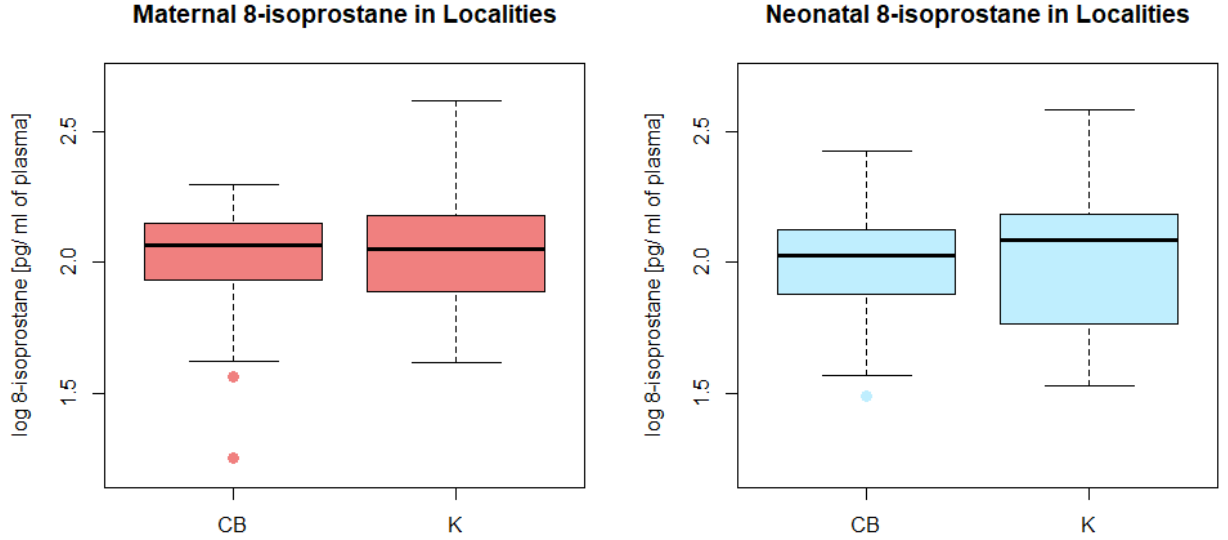
Figure 4. Maternal and neonatal plasma concentrations of 8-isoprostane in localities. Using the multiple regression model, it was found that 42% (40% Adjusted R-squared) of neonatal 8-isoprostane levels variability was explained by pp-DDT and protein in- take ( p < 0.001). The pp-DDT intake had a much stronger effect in this regression model ( p = 0.0000047), but the protein intake contribution was also statistically significant ( p = 0.00044) [Figure 5].